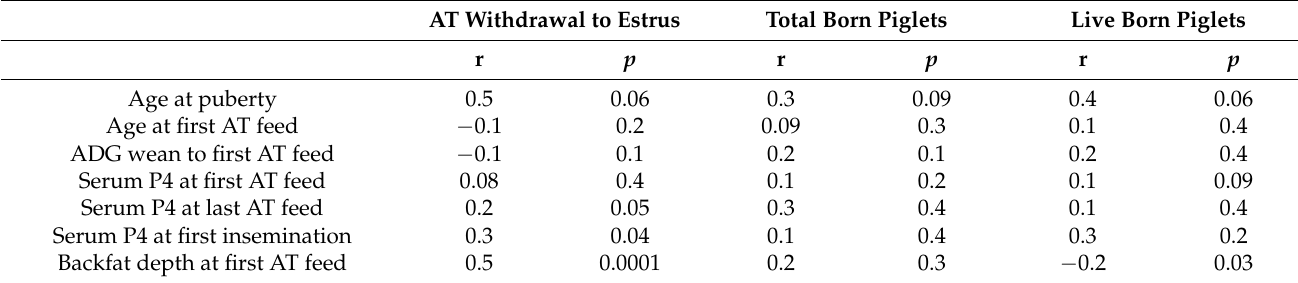
Table 1. Correlation of age of gilts, average daily gain (ADG), serum progesterone (P4) concentration and backfat thickness with the altrenogest (AT) withdrawal to estrus interval and litter size.